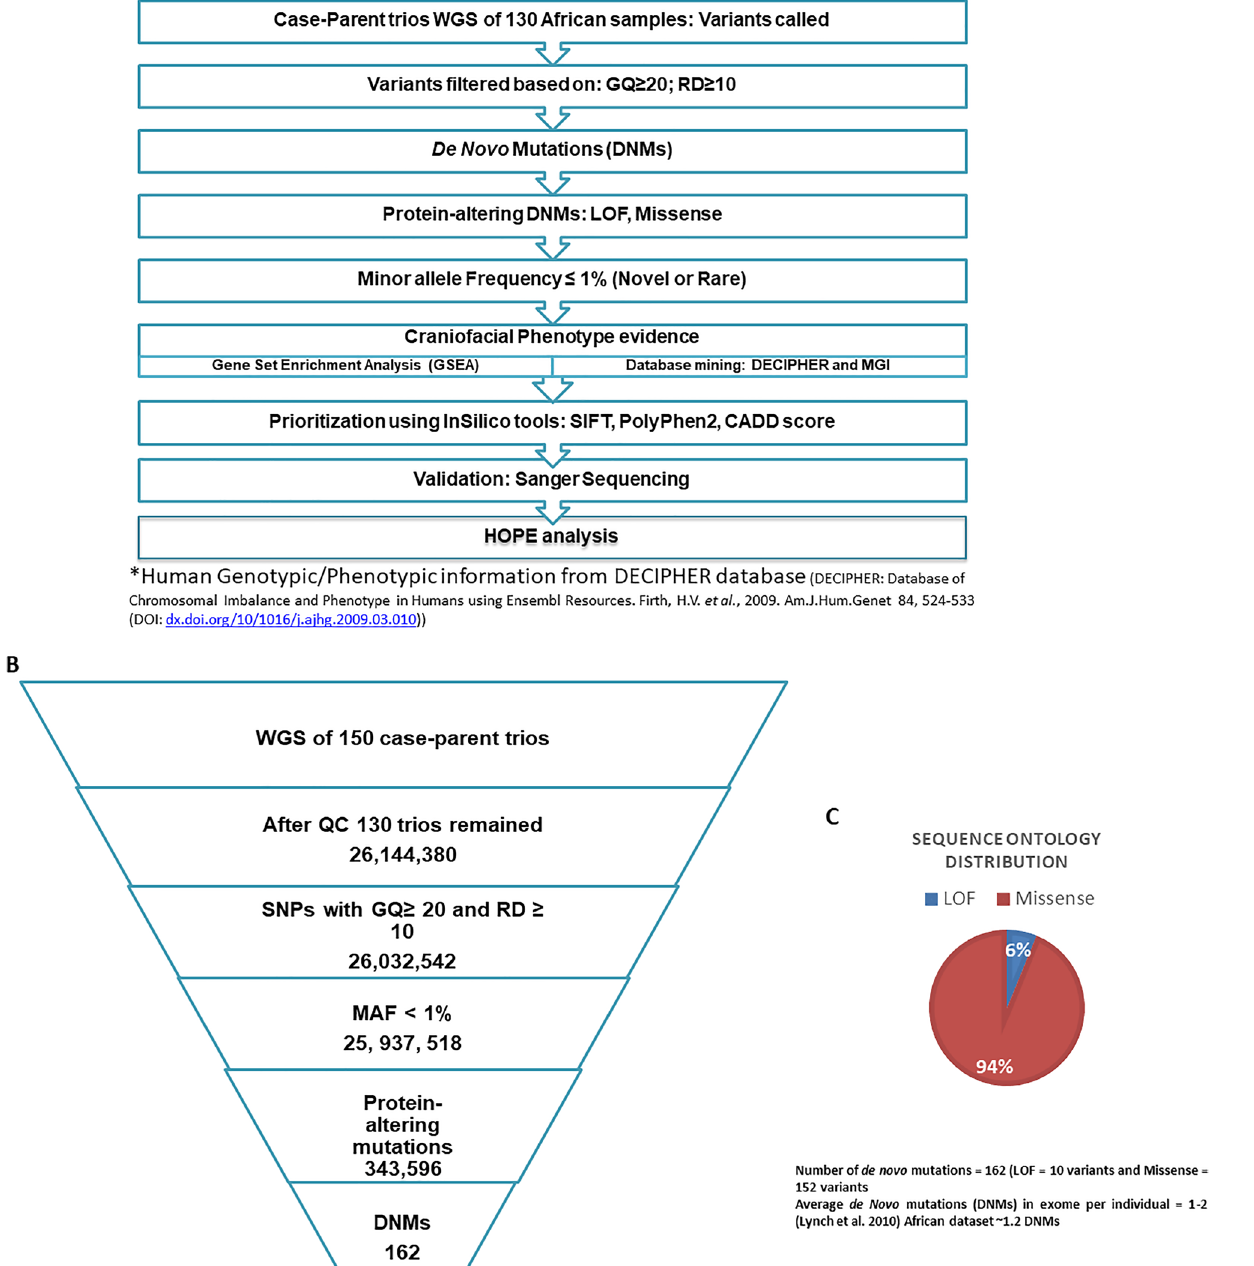
Figure 1. Case-parent trios’ definition, cleft sub-types, and Data filtration pipeline. ( A ) Data filtration pipeline used to identify the high confidence de novo mutations (DNMs) that contribute to the risk of nsCL/P. ( B ) Details of the number of variants from each data filtering steps which resulted in 162 DNMs in protein-coding genes. ( C ) Pie chart showing the distribution of the effects of the de novo Variants. Majority of the DNMs (94%) cause amino acid changes which alters the protein structures and functions while 6% cause loss of function mutation in the protein-coding